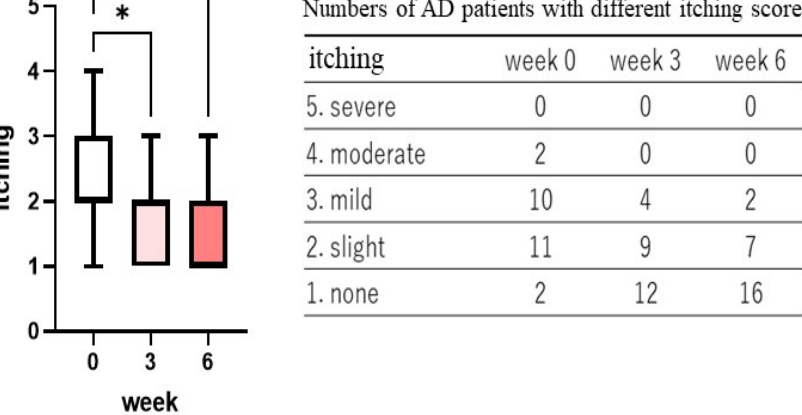
Figure 6. Clinical effects of the POLG nano-emulsion on itchiness of the skin of AD patients. Itchiness sensations were assessed by a dermatologist (KN) after querying each subject at 0, 3, and 6 weeks, and were scored on a 1–5 grading basis (1 = none; 2 = slight; 3 = mild, 4 = moderate; 5 = severe). n = 25; * p < 0.05, ***: p < 0.001 compared to week 0; all data were analyzed using Dunn’s multiple comparisons test.